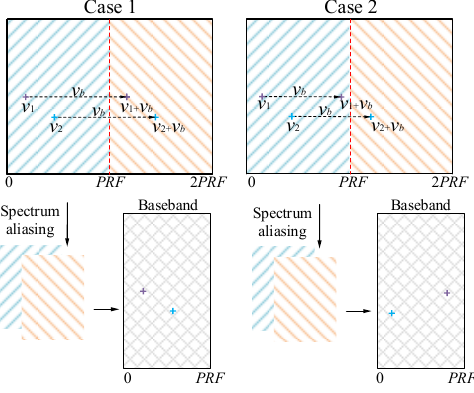
Figure 5. Spectrum aliasing.